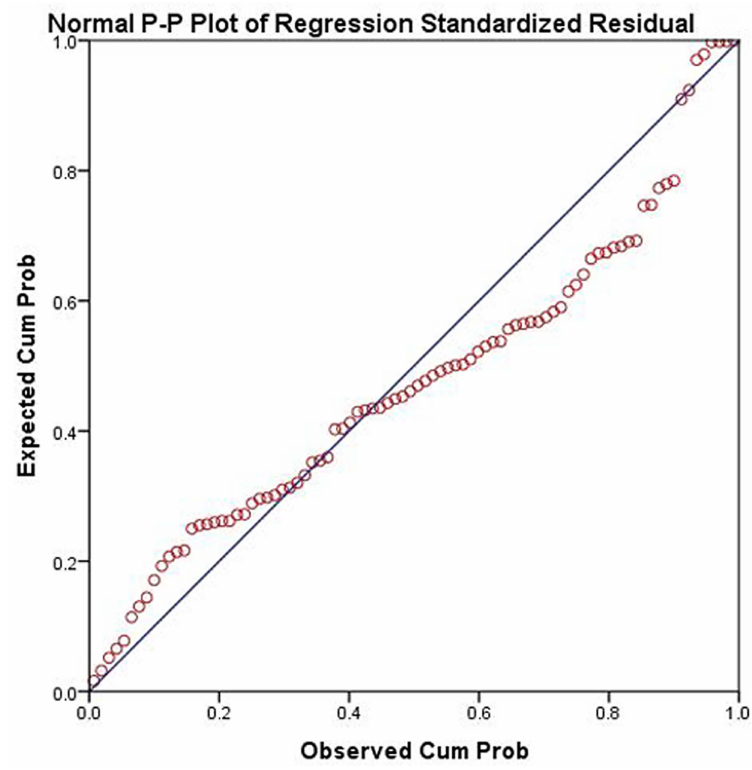
Fig 8. Residual diagram of model fitting of multi factor regression analysis of BF value. The result displaysall the points of distribution on both sides of central line, the residual plots obey